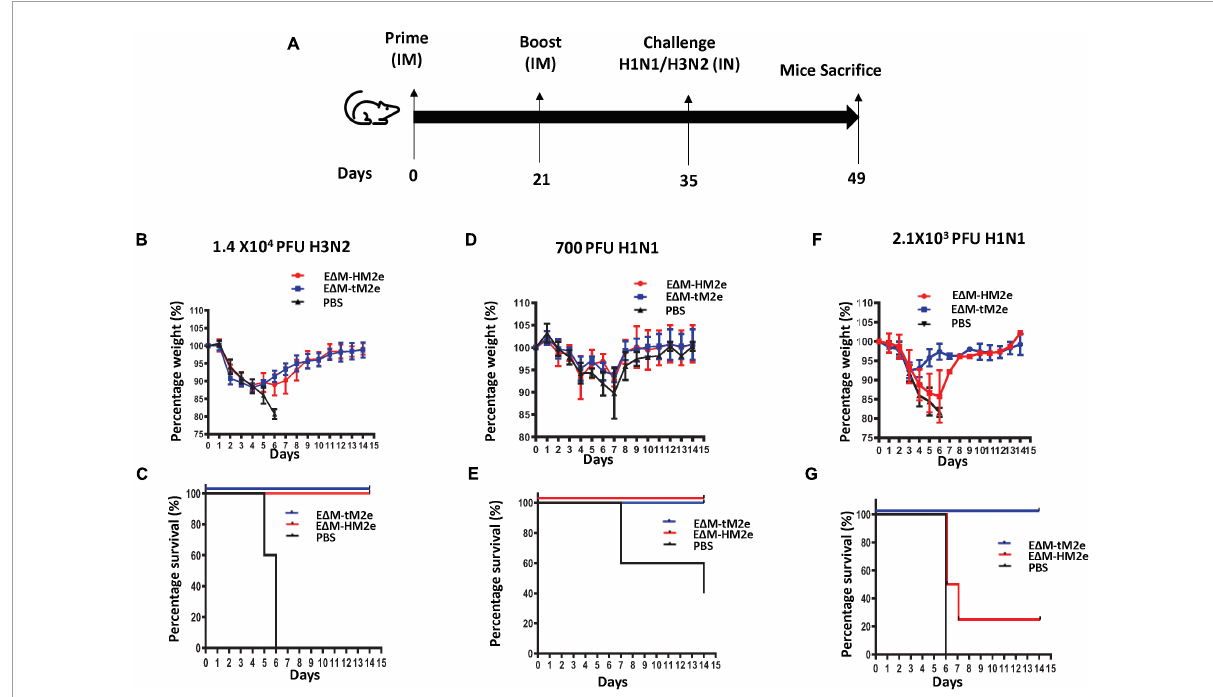
FIGURE6 Mice immunized with rVSV-E (cid:49) M-tM2e or rVSV-E (cid:49) M-HM2e were protected against challenges with H1N1 or H3N2 influenza virus strains. (A) The Balb/c mice were injected intramuscularly (IM) with rVSV-E (cid:49) M-tM2e, rVSV-E (cid:49) M-HM2e, or PBS on days 0 and 14 ( n = 4/5 mice per group). On day 28 post-immunization, the mice have challenged 1.4 × 10 4 PFU of H3N2 (B,C) ; 700 PFU of H1N1 (E,D) , or 2.1 × 10 3 PFU of H1N1 (F,G) . (B,D,F) Weight loss or gain of the mice. (C,E,G) The survival rates of mice after infecting with H1N1 or